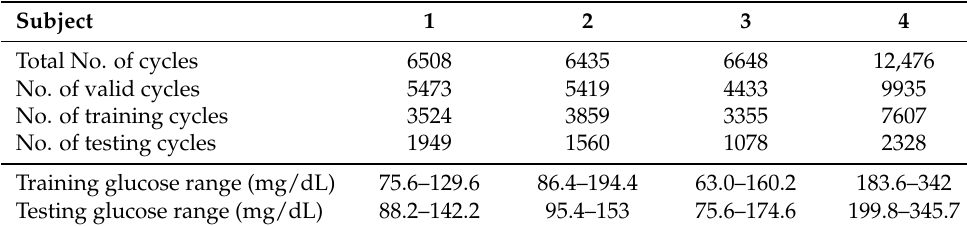
Table 3. Description of the training and test